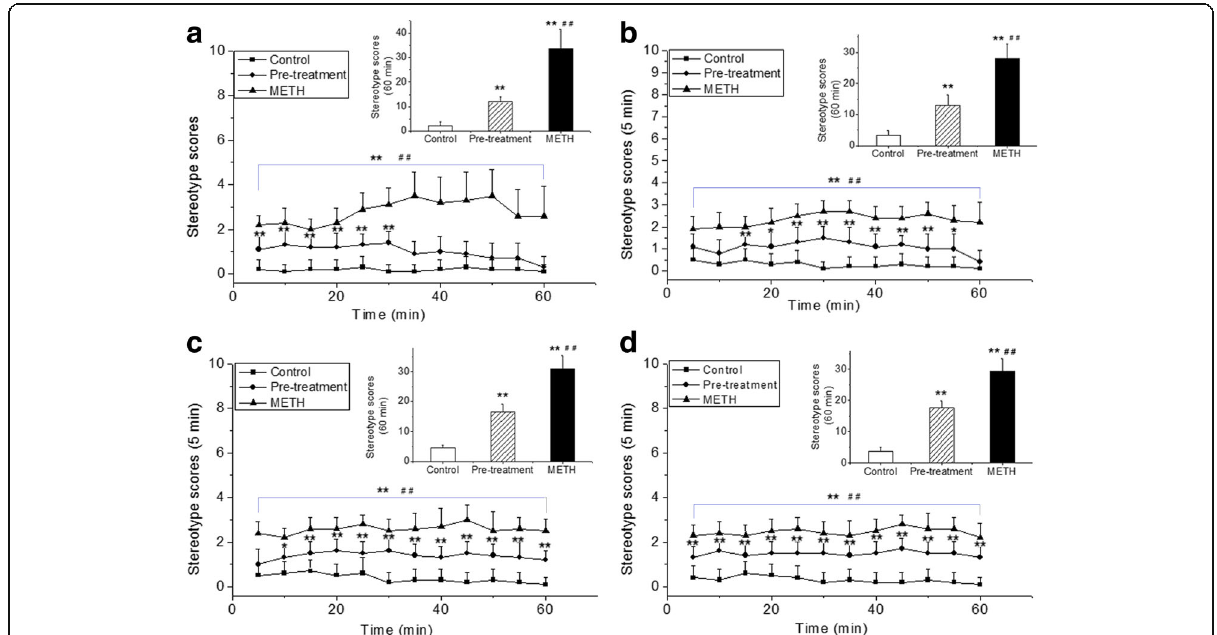
Fig. 1 Effects of Jitai tablet (JTT) on stereotyped behavior after each methamphetamine (METH) injection. After the first ( a ), second ( b ), third ( c ) and fourth ( d ) injection of METH, rats in the METH group all exhibited obvious stereotyped behavior and the control group did not show any behavioral changes, whereas animals in the JTT pre-treatment group had attenuated stereotyped behavior in comparison with the METH group. Data are expressed as mean±SD ( n =10). METH group or JTT pre-treatment group vs. control group: ** p <0.001; METH group vs. JTT pre-treatment group: ## p